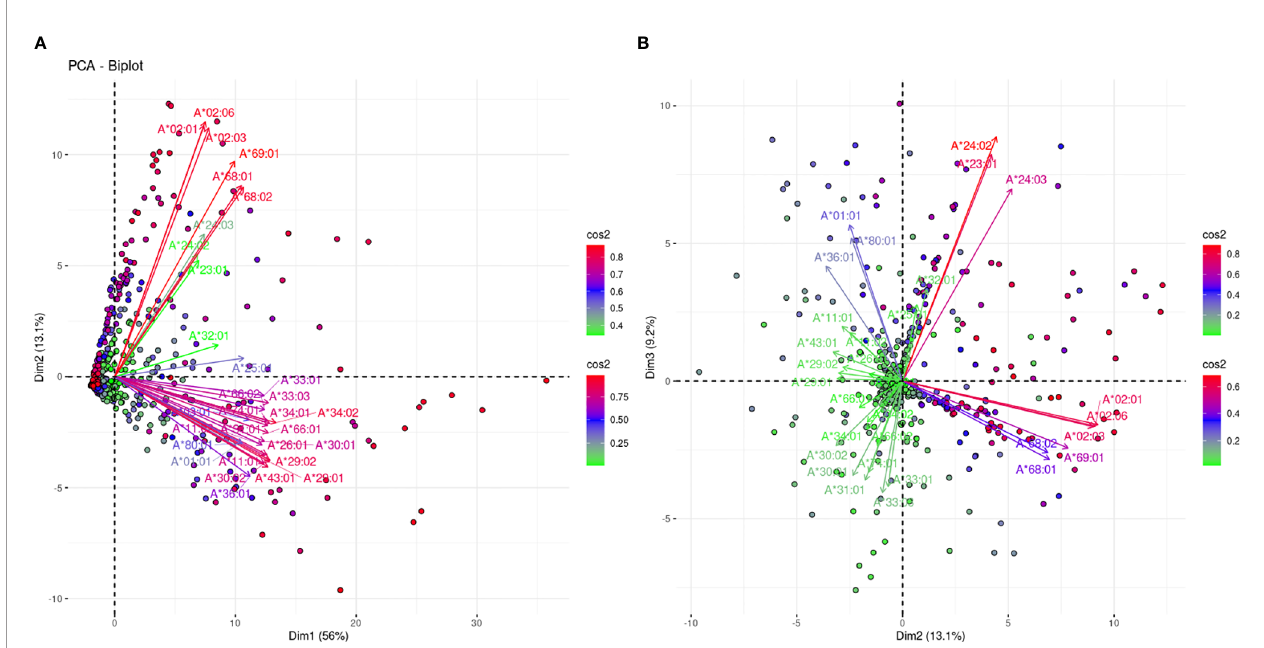
FIGURE 2 | PCA biplot projections of the anti-HLA-A antibody response. Panel (A) on the left represents the fi rst and second principal components de fi ned plane, while Panel (B) on the right represents the de fi ned plane of the second and third principal components. The points represent projections of individual reactions, and arrows represent the different anti-HLA-A responses. The color vectors on the right side of both panels represent the cos2 value of the explained variance for variables and individuals